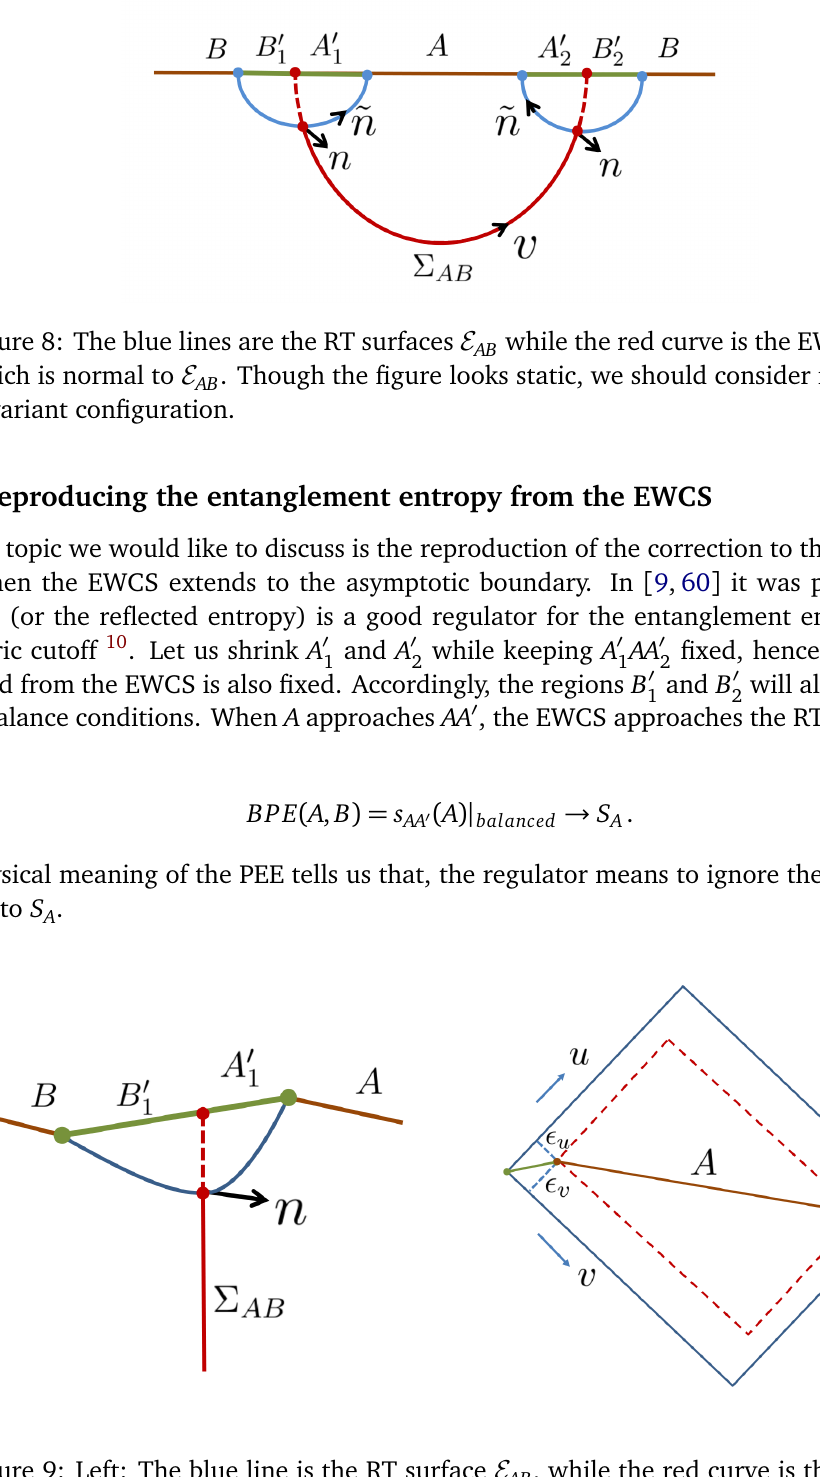
. The cutoff region A (cid:48) AB